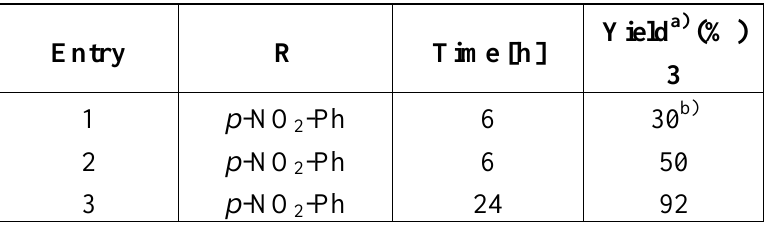
Table 5. Bayliss-Hillman Reaction of Aldehydes with Methyl Vinyl Ketone in